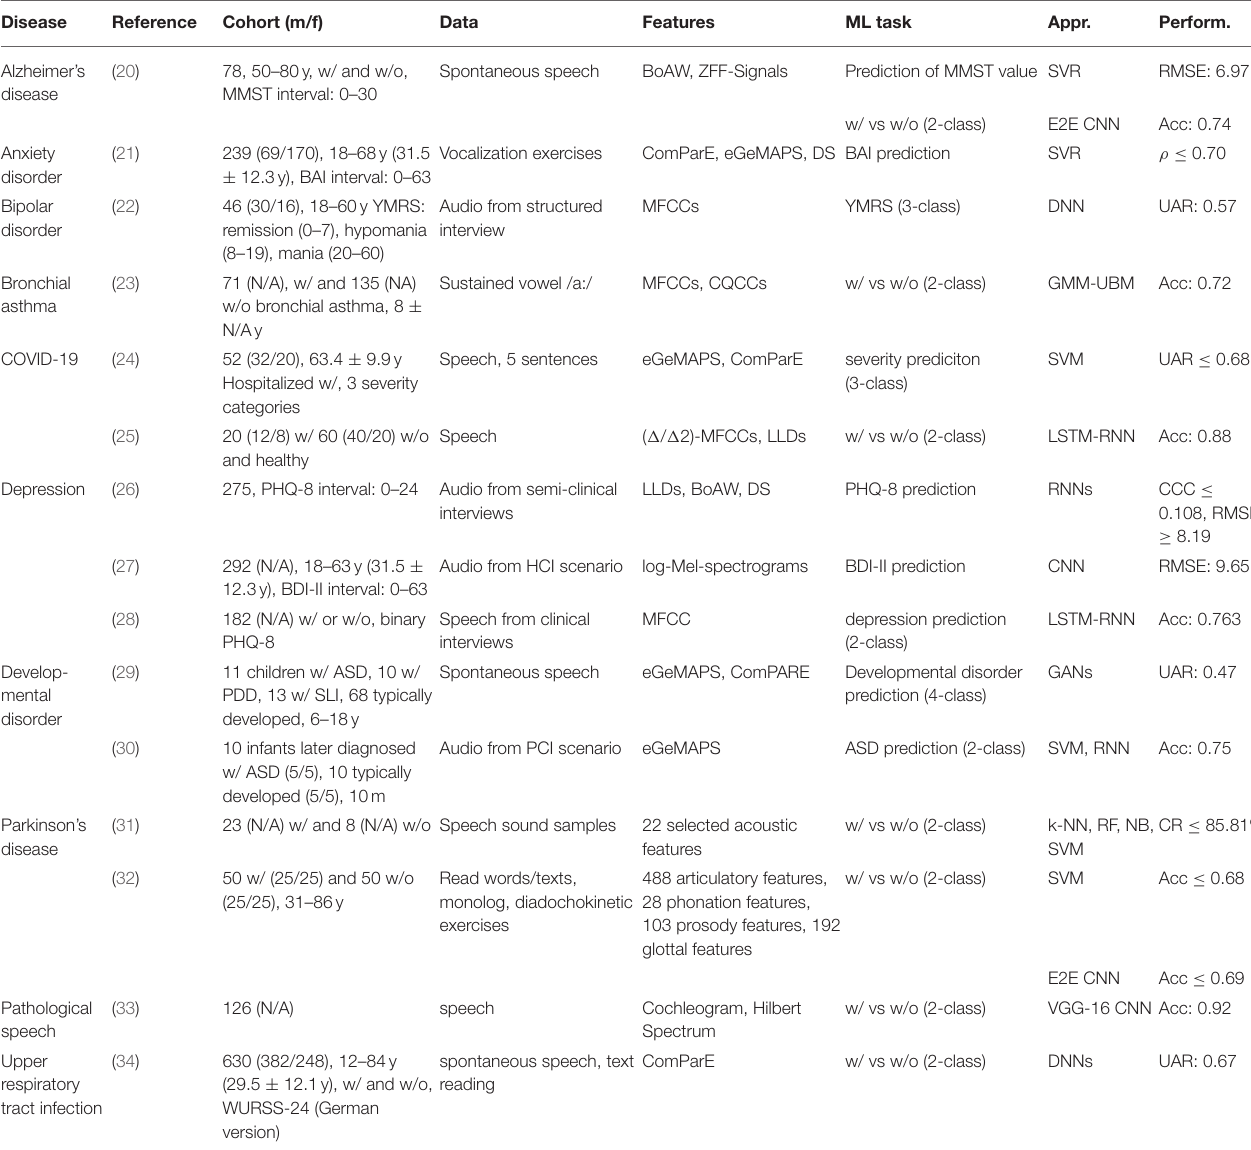
TABLE 1 | Overview of recent speech-based disease detection studies.